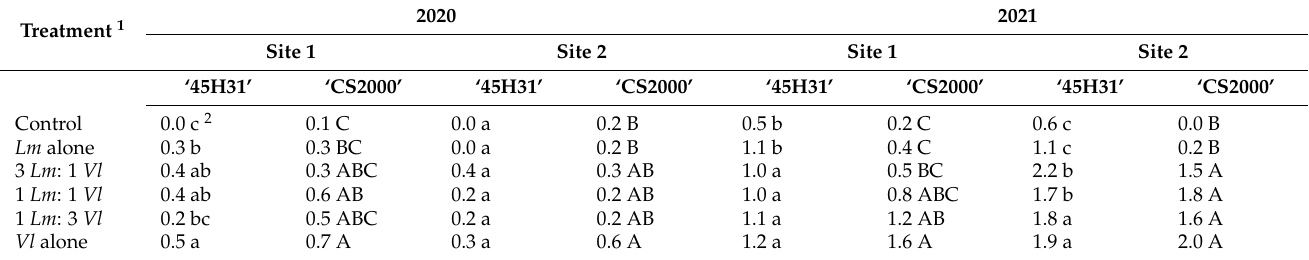
Table 3. Verticillium stripe severity (0–4) on the canola hybrids ‘45H31’ and ‘CS2000’ following inoculation with Leptosphaeria maculans ( Lm ) and/or Verticillium longisporum ( Vl ) alone and in various combinations under field